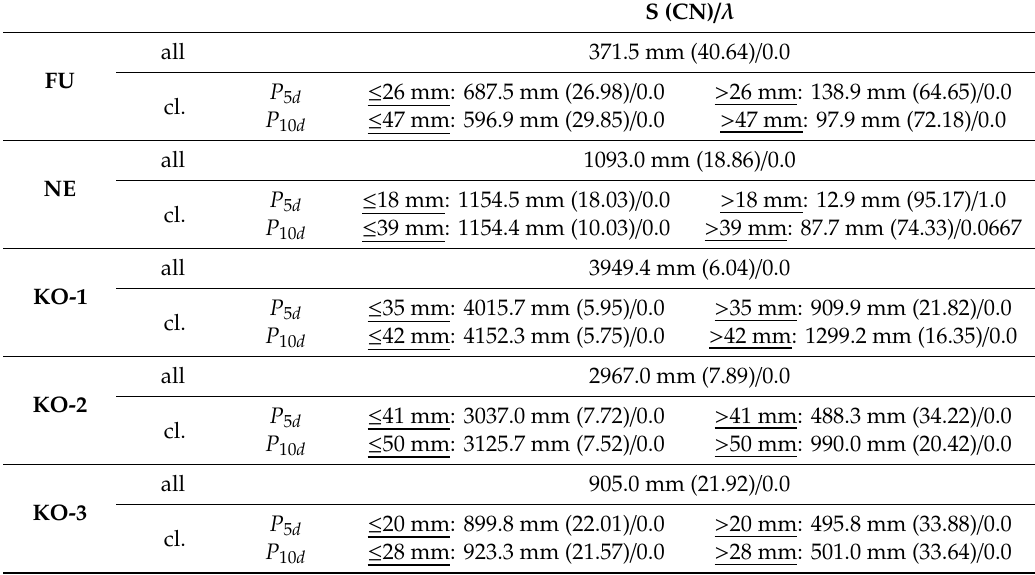
Table 9. Pairs of S and λ values identified by the model fitting iterative procedure in the experimental catchments. Clustered (cl.) and non-clustered (all) events were used. The cluster delimitation was done using the P 5 d and P 10 d thresholds.